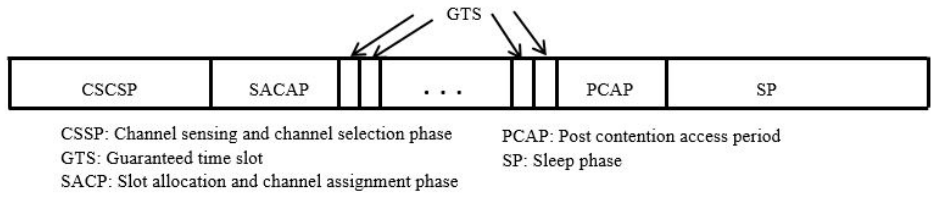
Figure 9 . Superframe structure of the multi-constrained QoS-aware MAC protocol. Figure 9. Superframe structure of the multi-constrained QoS-aware MAC